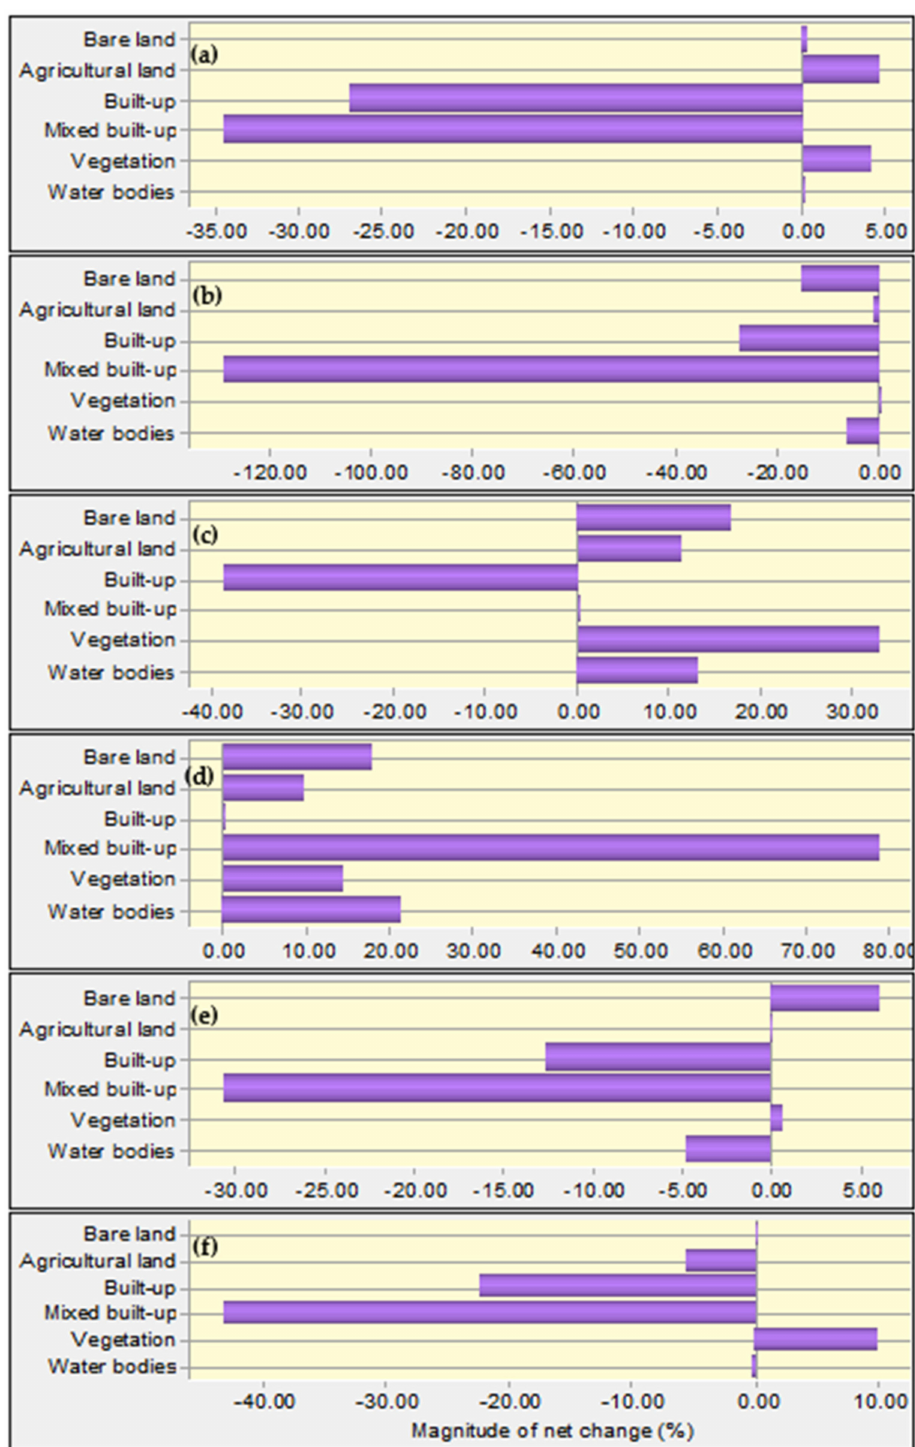
Figure 8. Contributors and their roles to the net change (%) in the LULCs of KMA between 1996 and 2016; contributors to the net change in, ( a ) water bodies, ( b ) vegetation, ( c ) mixed built-up, ( d ) built-up, ( e ) agricultural land, and ( f ) bare